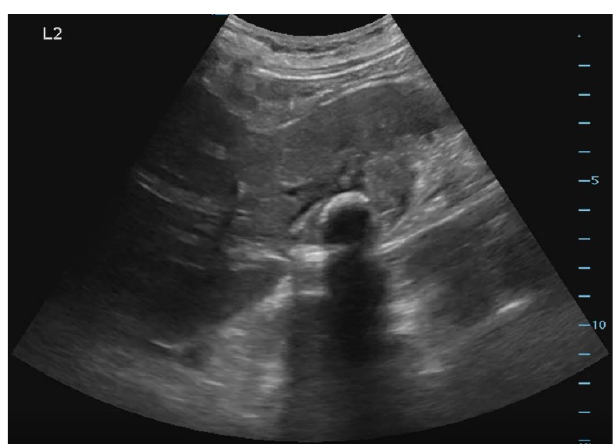
Figure . Gallbladder Bedside Ultrasound Examination.